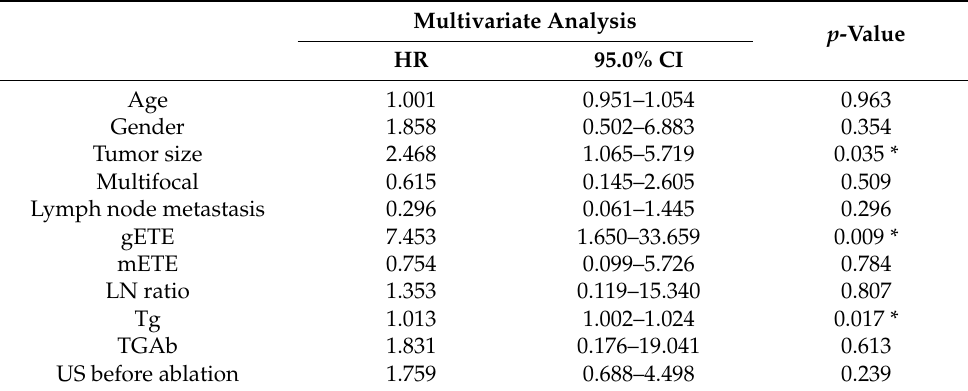
Figure 2. Prognostic value of US suspected mLN in RAI-positive group. Table 5. Cox regression analysis of clinical parameters in RAI-positive